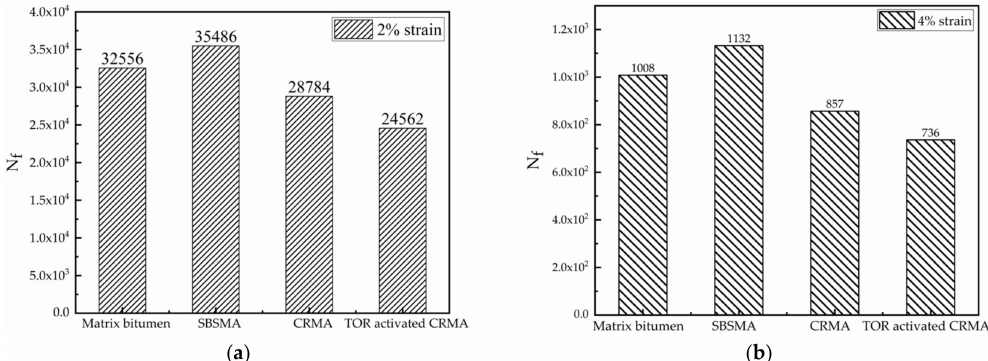
Figure 12. Fatigue life obtained using linear amplitude sweep (LAS) testing of asphalt binder at ( a ) 2% strain and ( b ) 4% strain